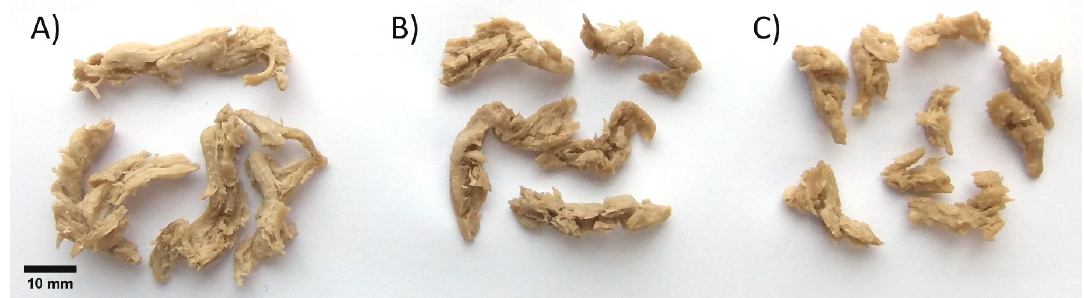
Figure 3. Rehydrated extruded materials from ( A ) control pea-oat powder, ( B ) phytase-treated powder, ( C ) fermented powder.